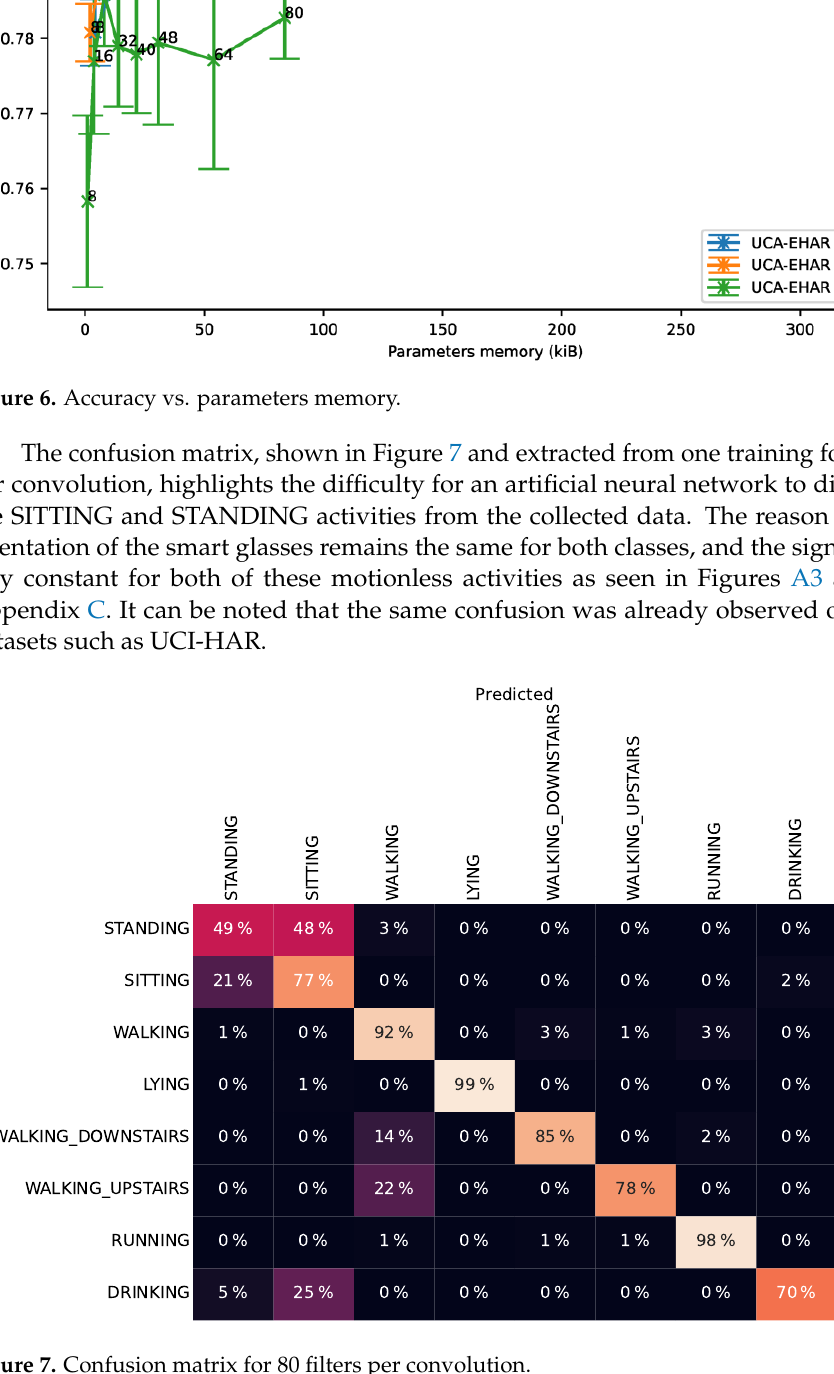
Figure 7. Confusion matrix for 80 filters per